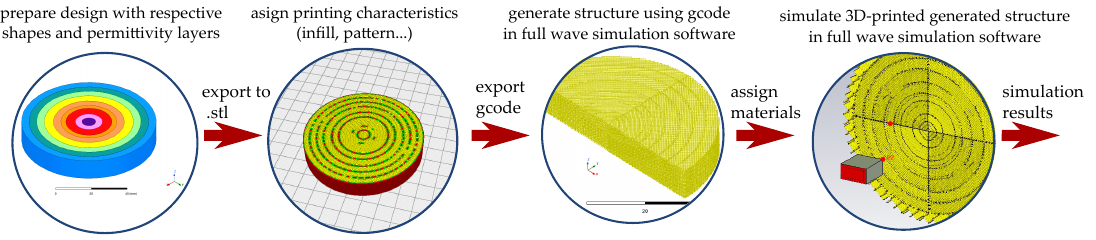
Figure 8. Flow diagram for full-wave simulation of 3D-printed generated structures.